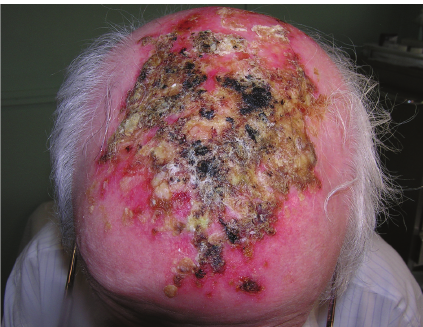
Figure 1: Erythematous patches and crusting developed a few weeks after topical treatment with imiquimod cream for actinic ker- atosis and lasted several months without spontaneous resolution.